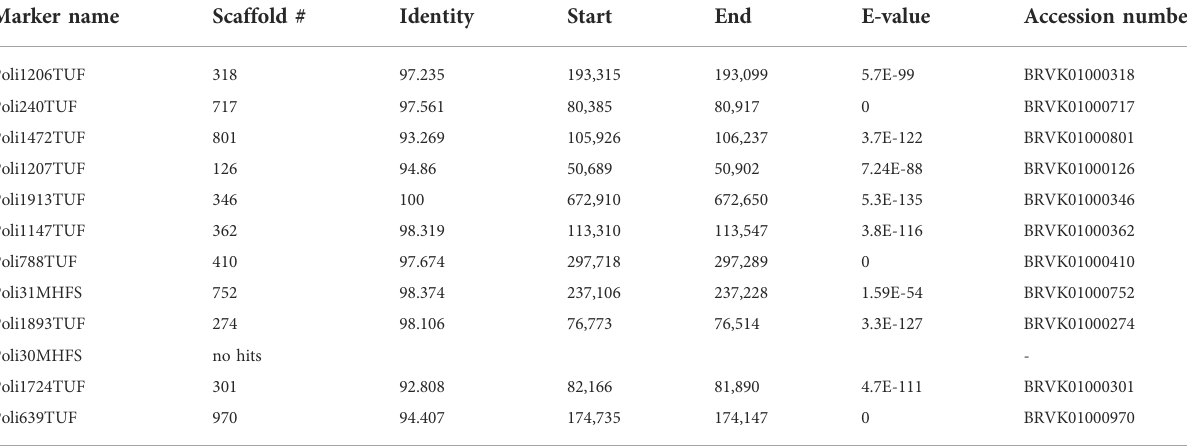
TABLE 2 Detailed list of scaffolds blasted against 12 sex-linked microsatellite markers.